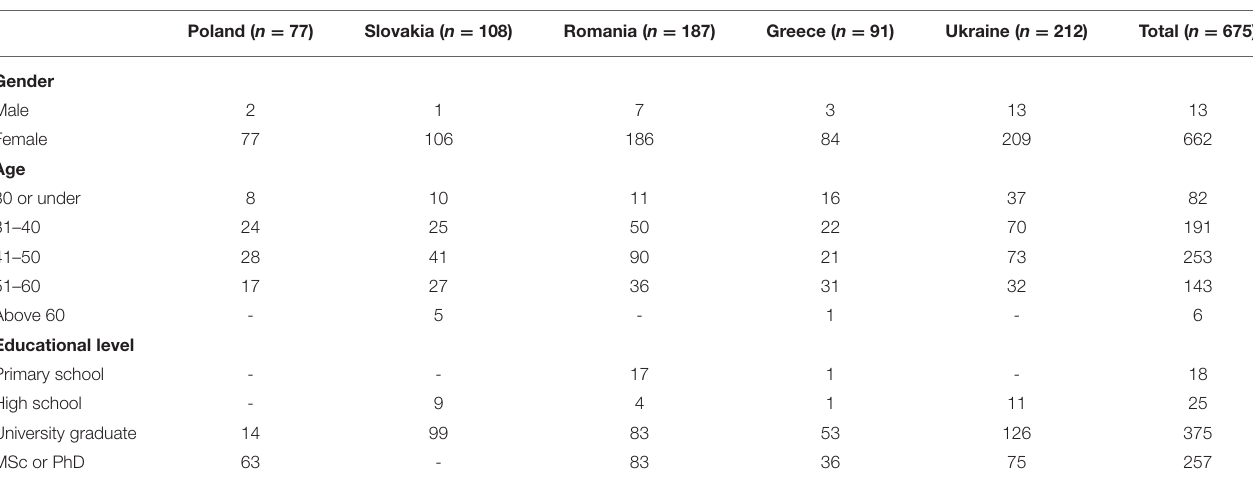
TABLE 6 | Demographic information of teachers who completed the Project Feedback Survey